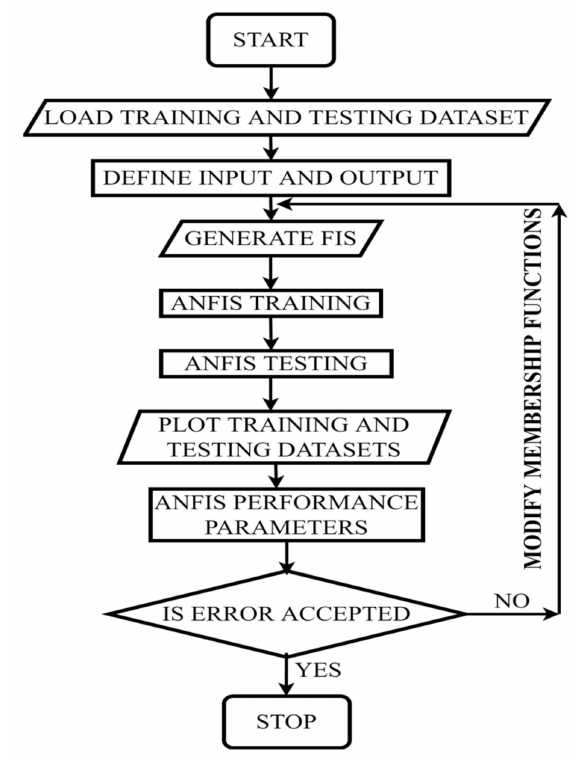
Figure 32. Flow chart of ANFIS technique.